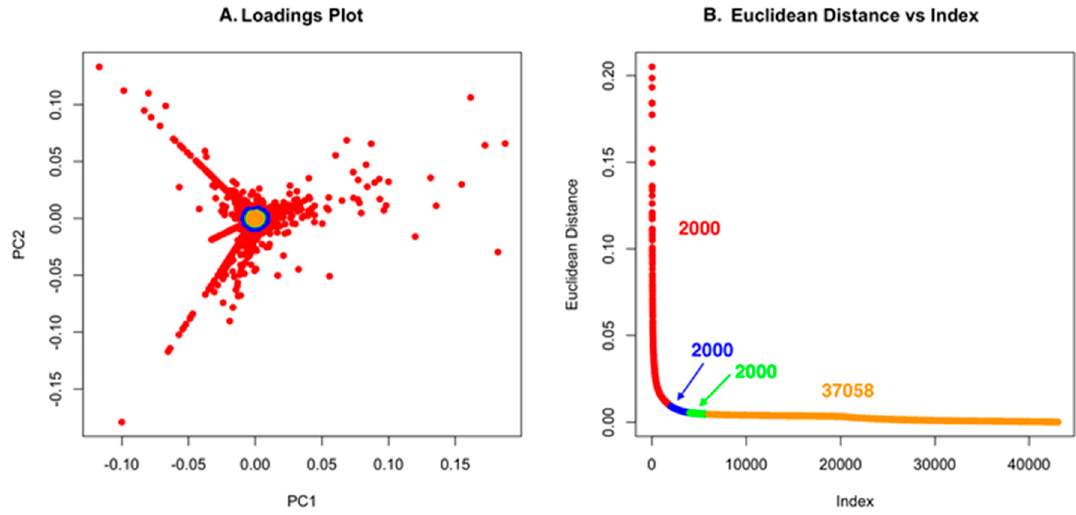
Figure 5. ( A ) The loadings plot for Dataset two with the 2000 most unique features colored in red; ( B ) The Euclidean distance versus index plot is color-coded to match the points in the loadings plot. This example shows that 37,058 features are located in the center of the PCA plot and, based on Euclidean distance, contribute little to variance, meaning that they are not unique to any strain.